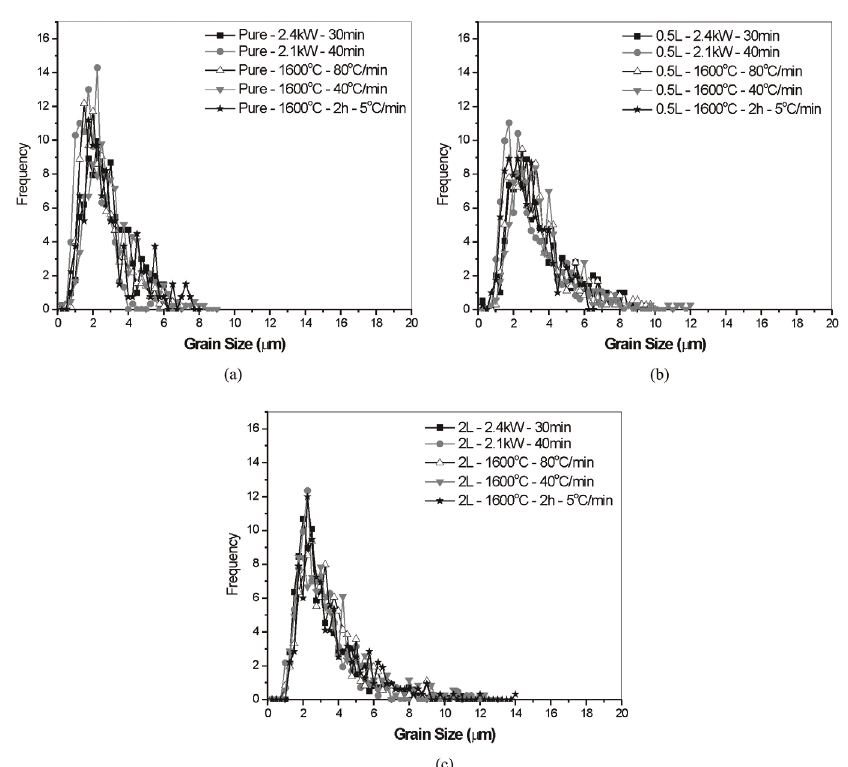
Figure 9. Grain size distribution of sintered La